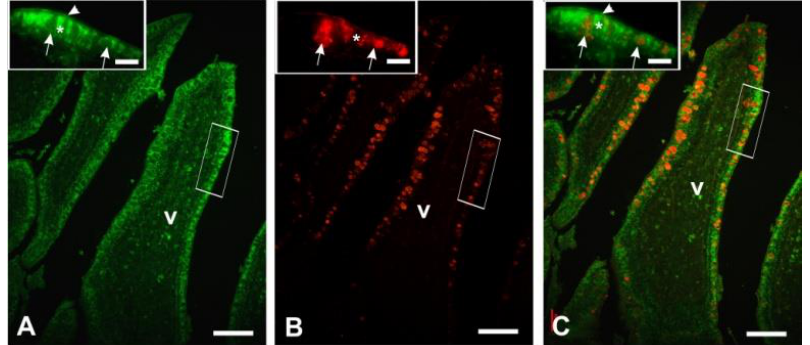
In P guinea fowls the number of distinguishable Con A-positive GCs significantly ( p < 0.05) increased in the ileum and the caecum (Figure 6), whereas the fluorescence inten- Figure 9. Con A-FITC ( A ), PNA-TRITC ( B ), Con A-FITC and PNA-TRITC merged pictures ( C ) Figure 9. Con A-FITC ( A ), PNA-TRITC ( B ), Con A-FITC and PNA-TRITC merged pictures ( C ) showing the faintly visible Con A-positive GCs in the duodenum of guinea fowls. Insets represent sity increased in the GCs of duodenum and decreased in the ileal and the caecal GCs showing the faintly visible Con A-positive GCs in the duodenum of guinea fowls. Insets represent the high magnification of rectangle-marked zones. v, villus; arrow, goblet cell; arrowhead, luminal (Figure 7; Figure 10). The epithelial cells and the luminal surface of the villi as well as the the high magnification of rectangle-marked zones. v, villus; arrow, goblet cell; arrowhead, luminal surface; asterisk, epithelial cell. Scale bars: A,B,C, 100 µm; insets: 40 µm. crypt cells (Figure 10O) displayed Con A-binding sites along the entire intestine, and surface; asterisk, epithelial cell. Scale bars: A,B,C, 100 µ m; insets: 40 µ m. their staining intensity was not affected by the administration of probiotics.